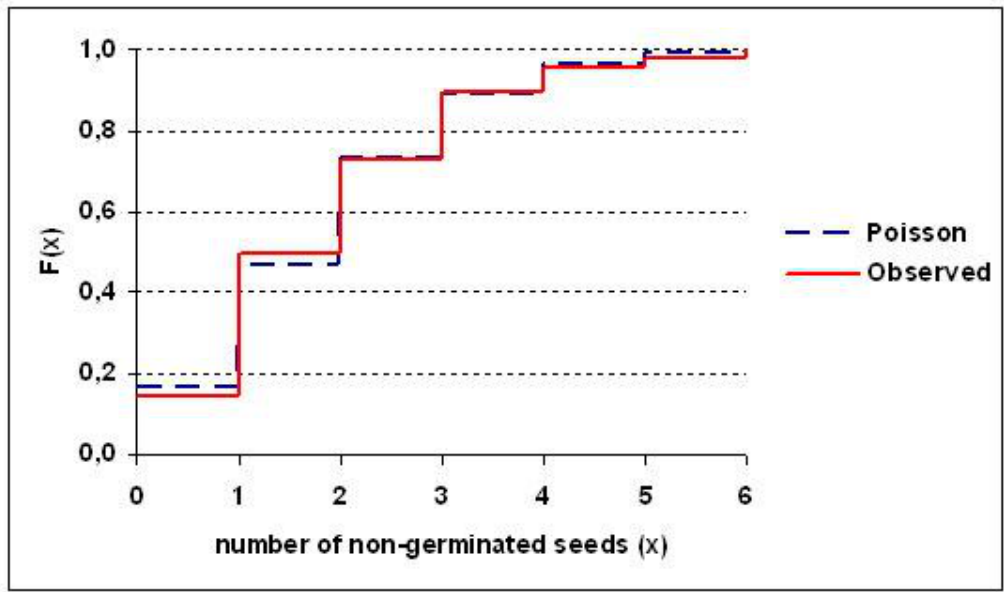
FIGURE 2. Empirical and Poisson distribution function (control group); goodness-of-fit of Poisson model to wheat germination